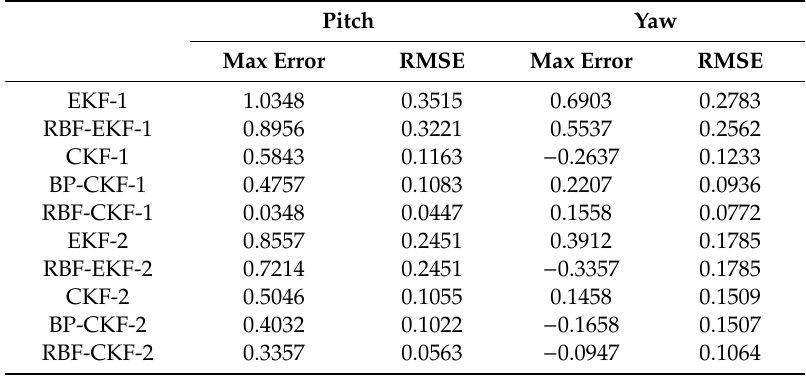
Figure 11. Motion trajectory of pitch axis and yaw axis.